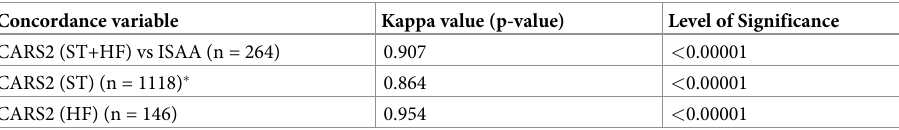
Table 5. Concordance of ISAA and CARS2; and Area under ROC (n =